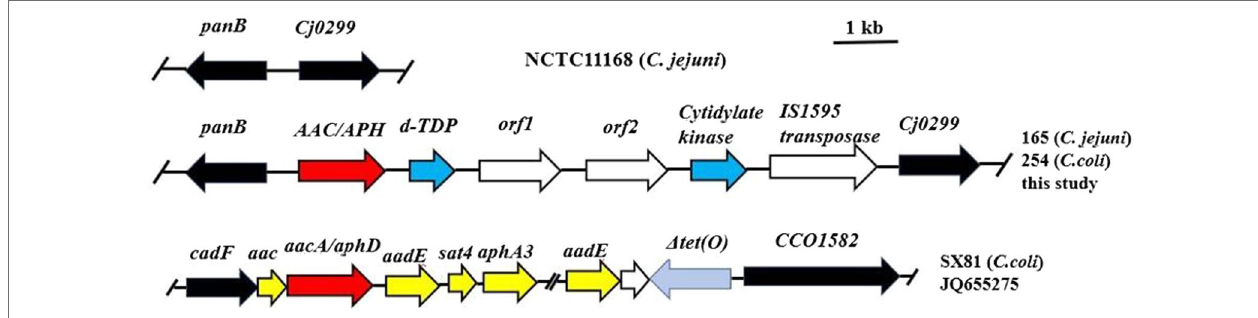
FIGURE 2 | Genomic organization of the aminoglycoside resistance insertion segment in C. jejuni 165 and C. coli 254 in comparison with the multidrug resistance genomic island of C. coli SX81 and C. jejuni 11,168. Arrows indicate the positions and directions of transcription of the genes. The locations of primers panB -F and cj0299 -R used to detect the insertion segment are